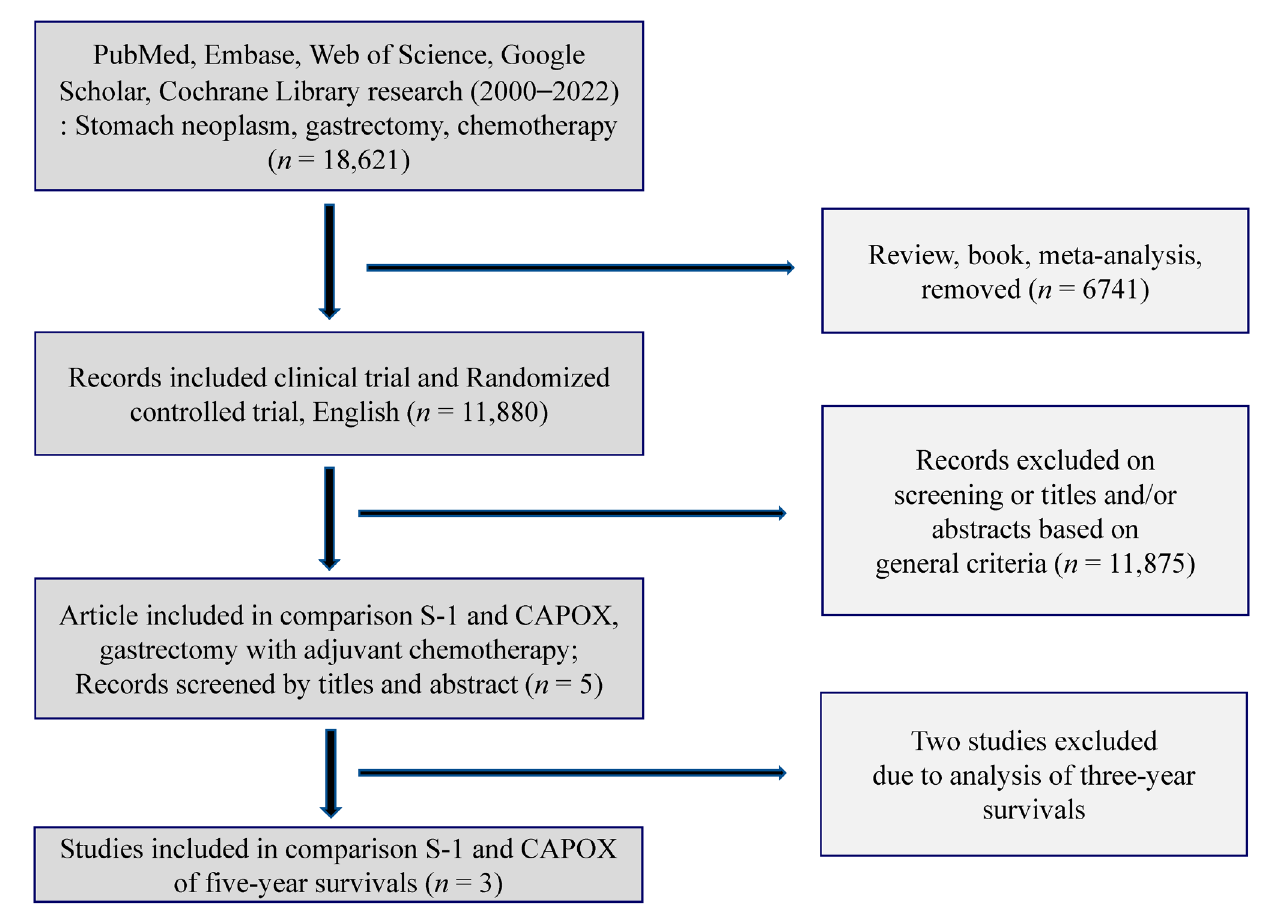
Figure 1. Flow chart of study selection. S-1,tegafur/gimeracil/oteracil; CAPOX, capecitabine plus oxaliplatin.